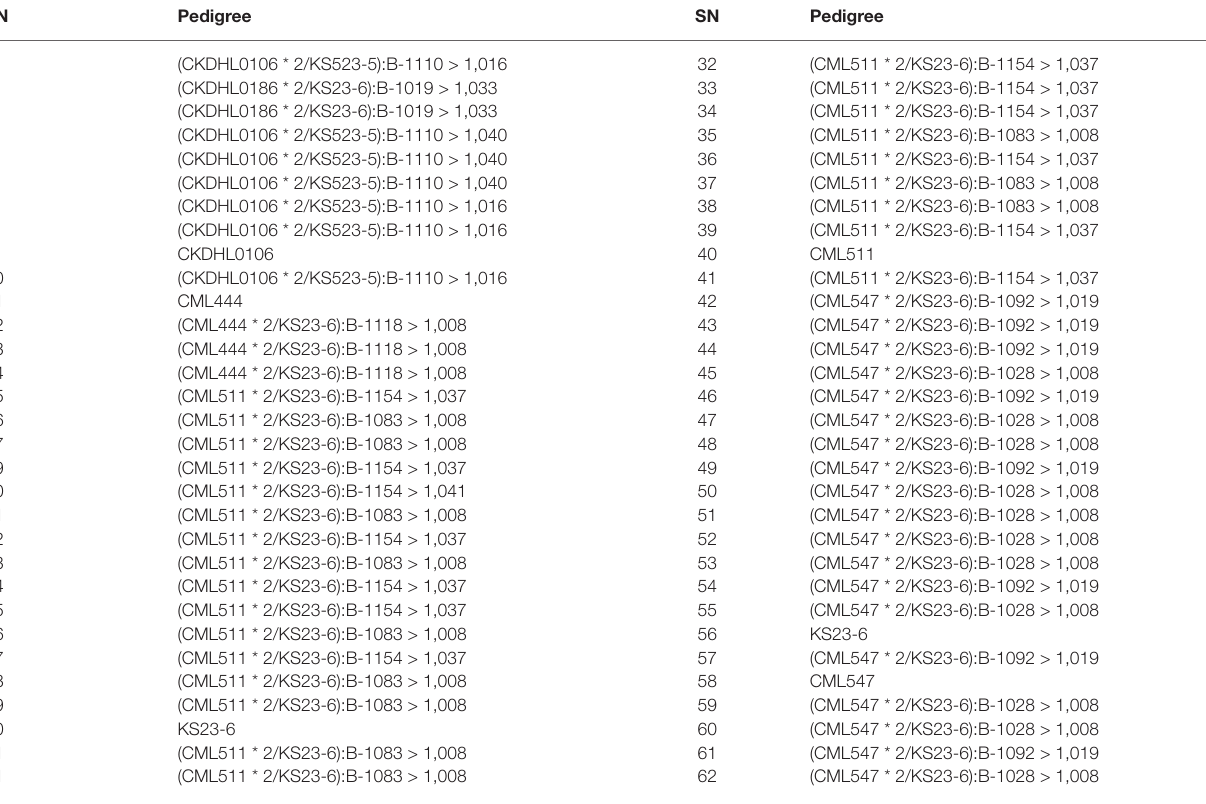
TABLE 2 | List of selected BC 3 F 2 lines including resistant and susceptible parents evaluated for two seasons under artificial inoculations for resistance to MLN in Naivasha in 2018. SN Pedigree